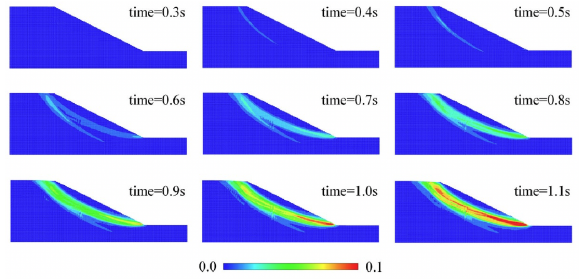
Figure 5. Development of failure surface depicted by total equivalent strain with reduction factor f = 1 : 9